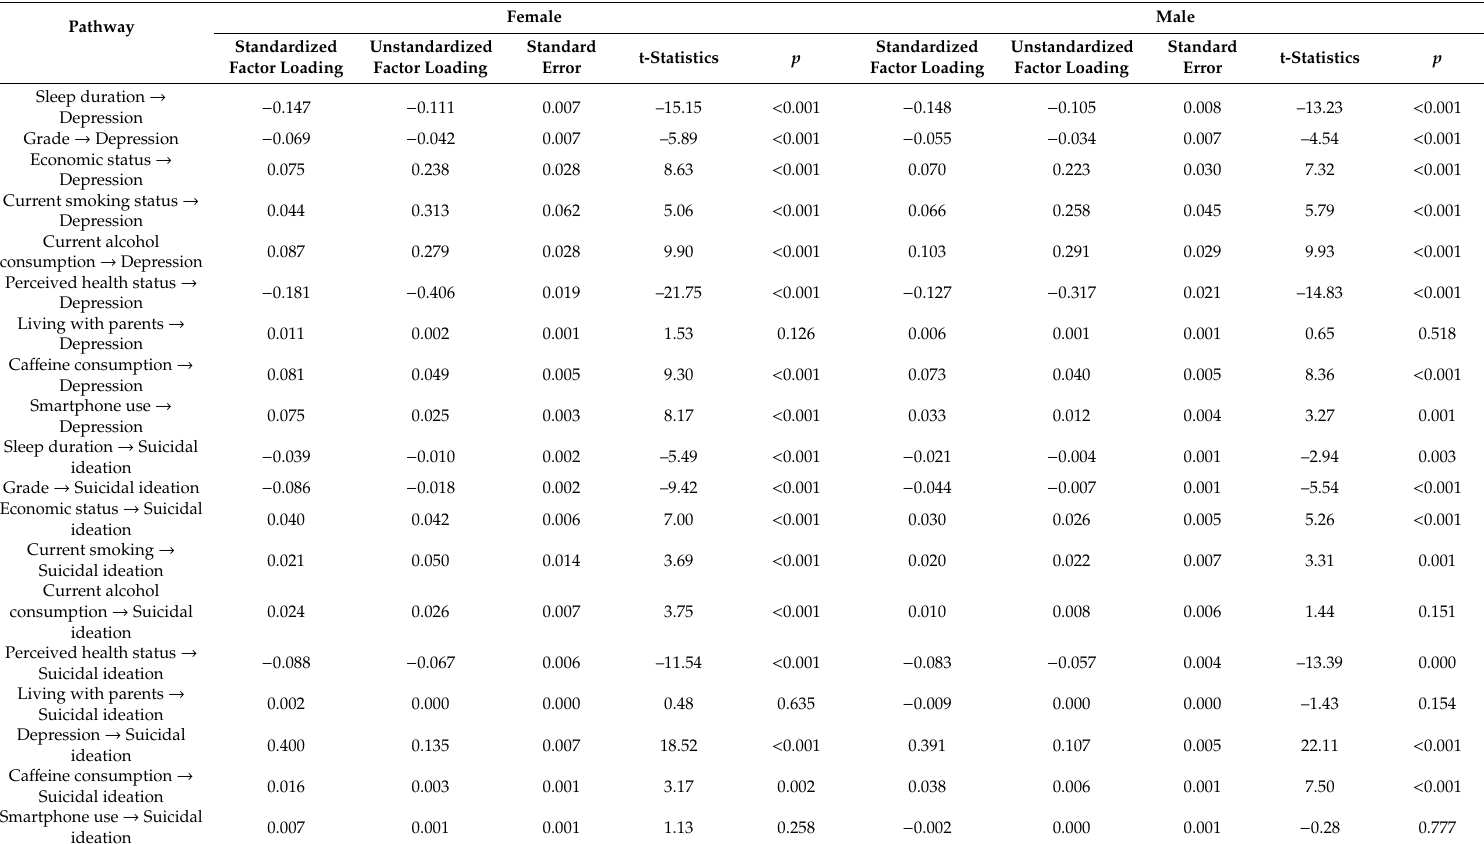
Table 5. Factor loading of the pathway analysis for both